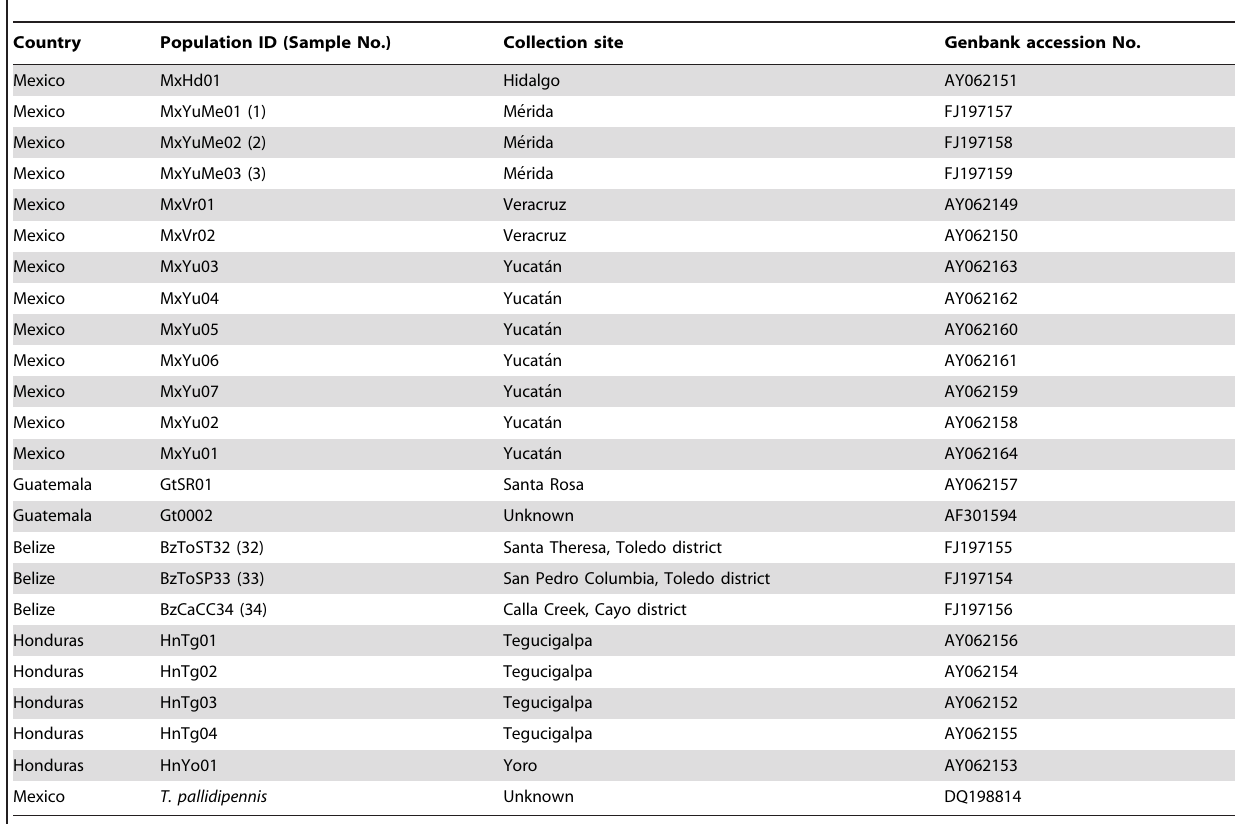
Table 2. Samples used for mt cyt b sequences analysis.